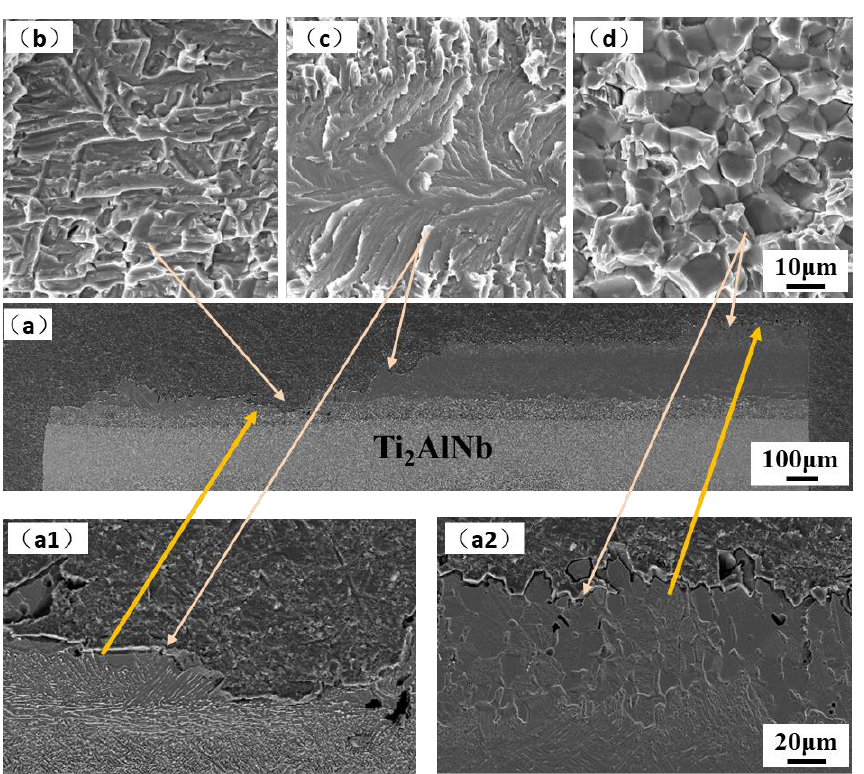
Figure 9. Fracture of 650 ℃ tensile samples: ( a ) cross-section, and ( b – d ) fracture surface. ( a1 ) cross-section near Ti 2 AlNb side; ( a2 ) cross-section near TiAl side.